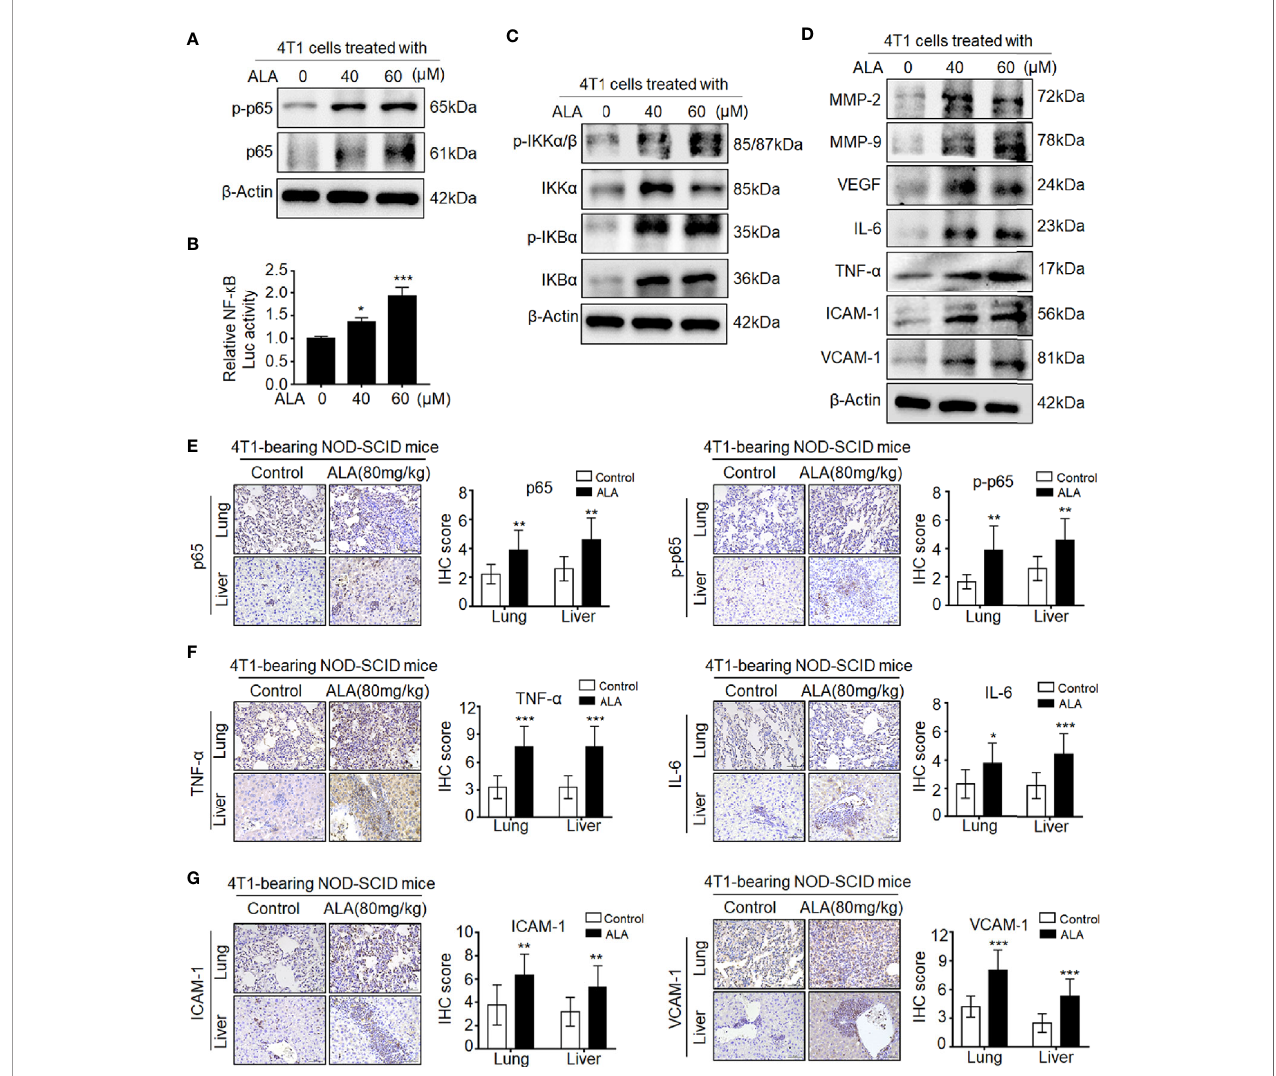
FIGURE 5 | Pharmaceutical NRF2 activation promotes NF- к B activation in vitro and in vivo . (A, B) NRF2 activator ALA promotes NF- к B activation in BC cells. (A) 4T1 cells were treated with ALA (0, 40, and 60 m M), and p-65 and p-p65 expressions were detected by Western blotting. (B) NF- к B transcriptional activation was analyzed by luciferase reporter gene assay. (C, D) ALA enhances NF- к B-associated proteins expression in vitro . 4T1 cells were treated with ALA (0, 40, and 60 m M) for 4 – 6 h. (C) NF- к B regulatory proteins and (D) NF- к B-responsive targets were detected by Western blotting. b -Actin was a loading control. (E – G) ALA induces NF- к B activation and its downstream targets expression in vivo . 4T1-bearing NOD-SCID mice were treated with ALA (80 mg/kg) via intraperitoneal (i.p.) administration. IHC staining was used to detect (E) p-65 and p-p65, (F) IL-6 and TNF- a , and (G) ICAM-1 and VCAM-1 in lung and liver metastatic tissues, respectively. Data are presented as mean ± SD of three independent experiments. Scale bar: 50 m m. Representative images are shown. *p < 0.05, ** p < 0.01, and ***p < 0.001 between the indicated groups determined by unpaired Student ’ s t-test or the one-way analysis of variance